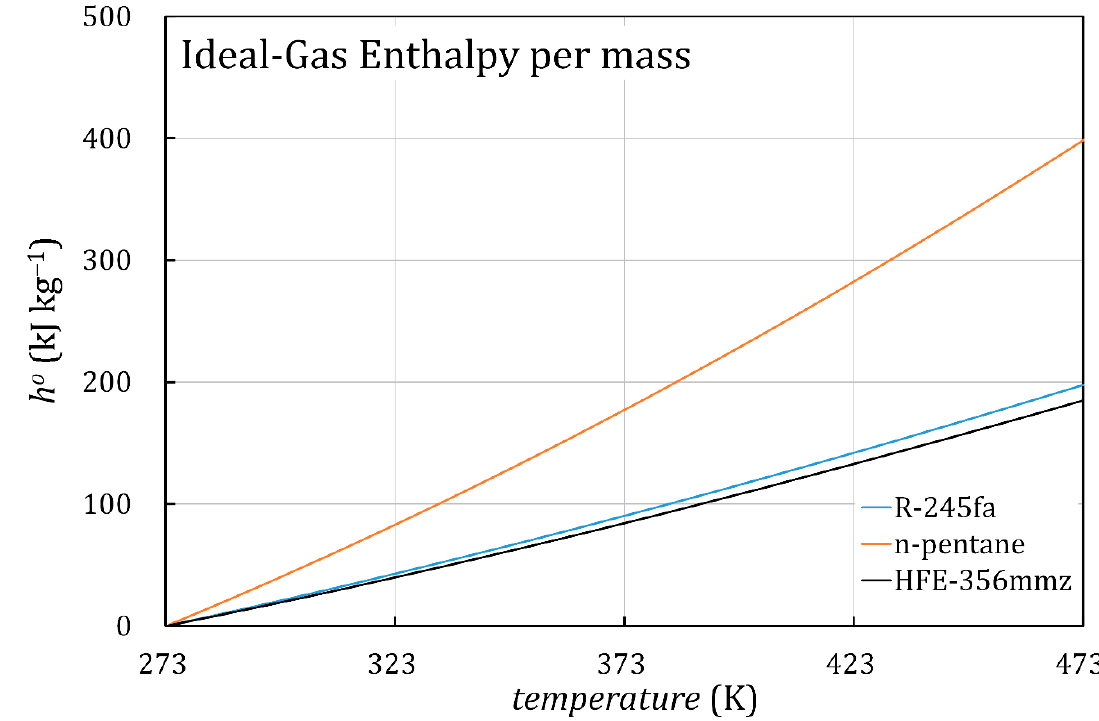
Figure 13. Comparison of the ideal-gas enthalpy per mass of HFE-356mmz with that of R-245fa and n-pentane.